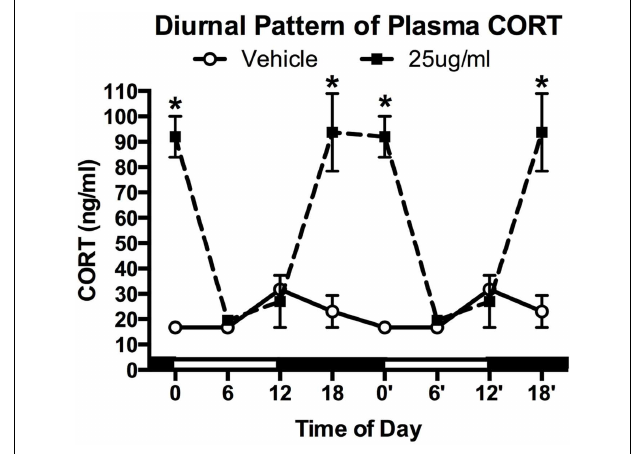
FIGURE 1 | Chronic low-dose CORT treatment in the drinking water maintains rhythmic, yet slightly higher, levels of plasma CORT . Treatment with CORT (25 µ g/ml) in the drinking water resulted in rhythmic diurnal changes in plasma CORT that reached a peak during the dark phase (ZT12–ZT0), but reached the same nadir levels as vehicle-treated mice (ZT6). Data from 0 (cid:48) to 18 (cid:48) are re-plotted from 0 to 18 to aid in visualization of the rhythm. Asterisks indicate statistically significant effects at the P < 0.05